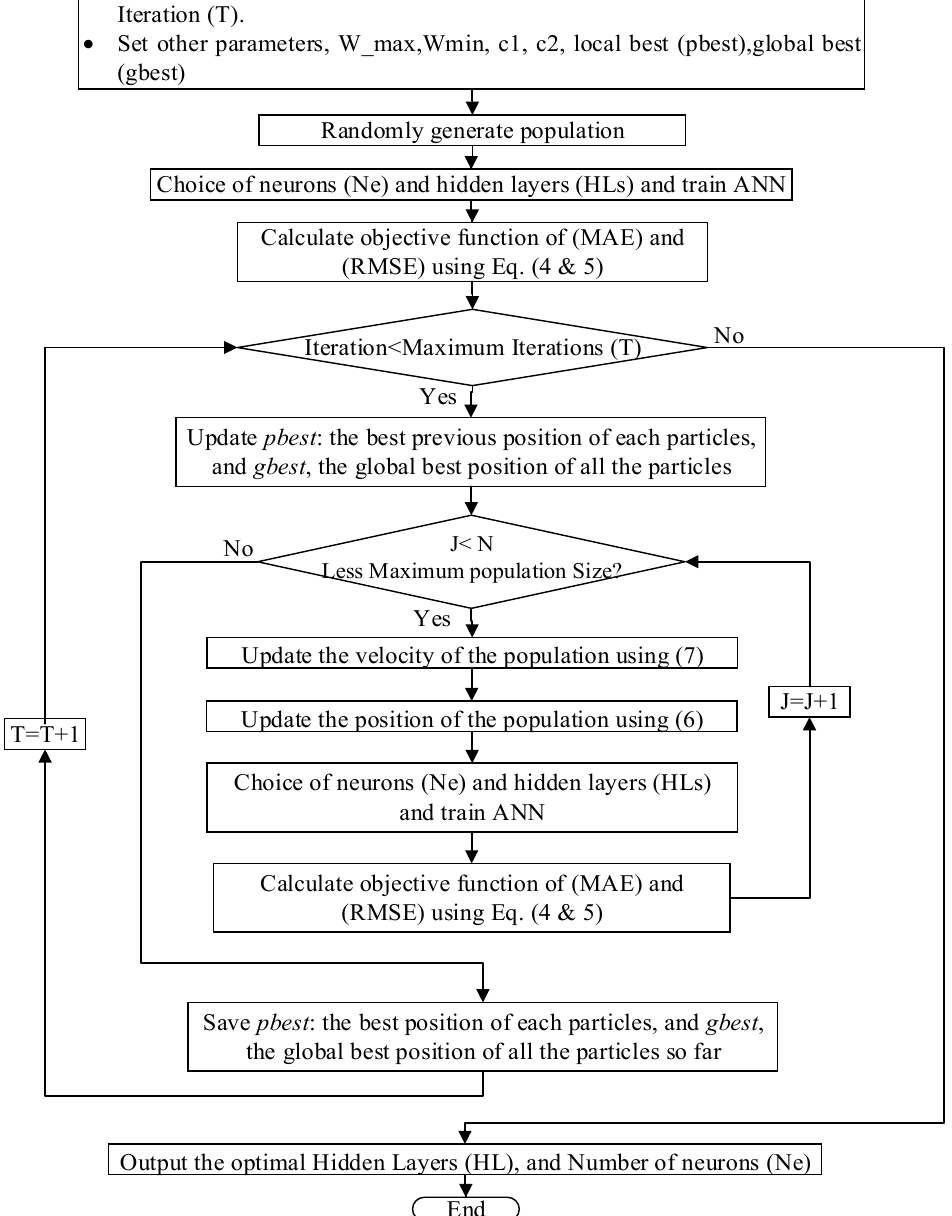
Figure 2. Flowchart of the hybrid particle swarm optimization and artificial neural network (PSO-ANN). Abbreviations: RMSE, root-mean-square error; MAE, mean absolute error; ANN, artificial neural network.